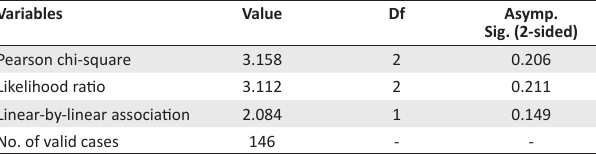
TABLE 2c: Management assistance: chi-square tests.